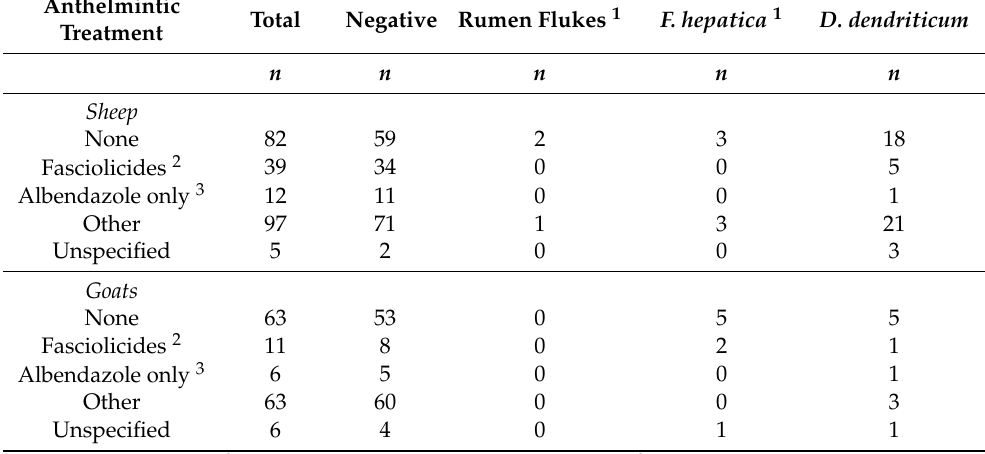
Table 5. Patent rumen and liver fluke infections on German sheep ( n = 223) and goat farms ( n = 143) related to recent anthelmintic treatment. Treatments carried out >6 months prior to sample collection were classified as